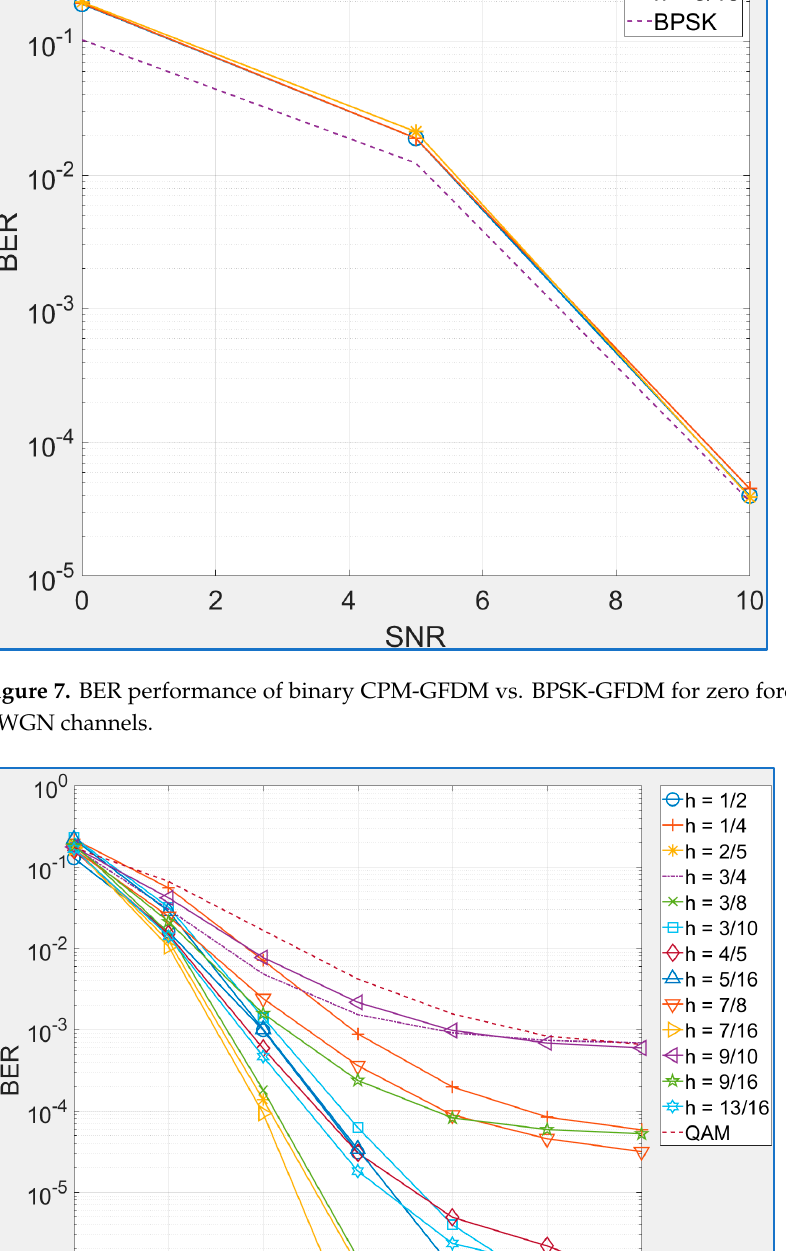
Figure 7. BER performance of binary CPM-GFDM vs. BPSK-GFDM for zero forcing receiver over AWGN channels.